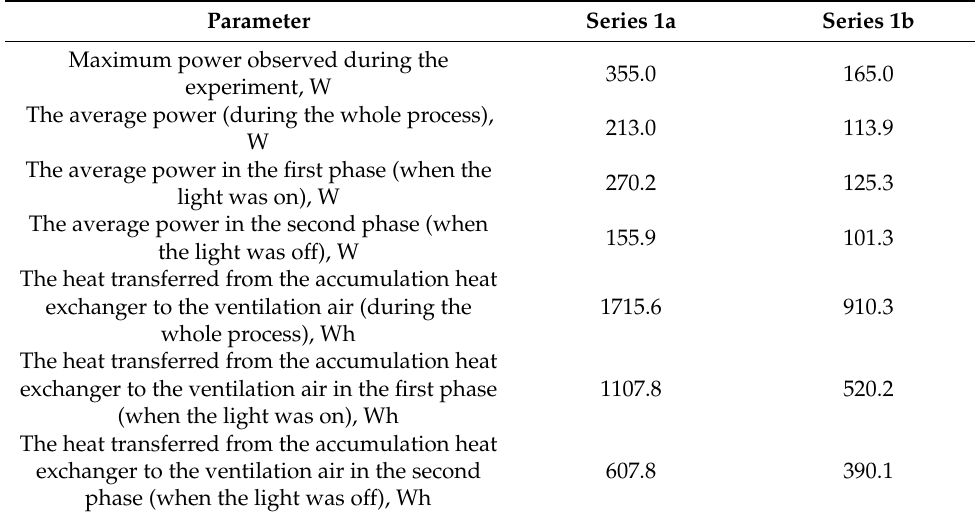
Figure 8. Variations in the power transferred from the SAH to the ventilation air when the SAH operated as a solar chimney (Series 1a) and a solar thermal wall (Series 1b). Table 6. Power and the heat transferred from the SAH to the ventilation air when the SAH operated as a solar chimney (Series 1a) and a solar thermal wall (Series